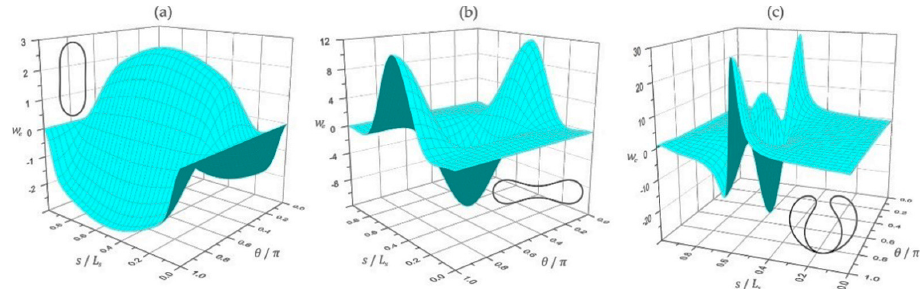
Figure 2. Extrinsic potential w e as a function of the arc length s and the nematic director orientation angle θ for ( a ) prolates, ( b ) oblates and ( c ) stomatocytes. Shell profiles are given within graphs for each shape. L s stands for the length of the profile curve.